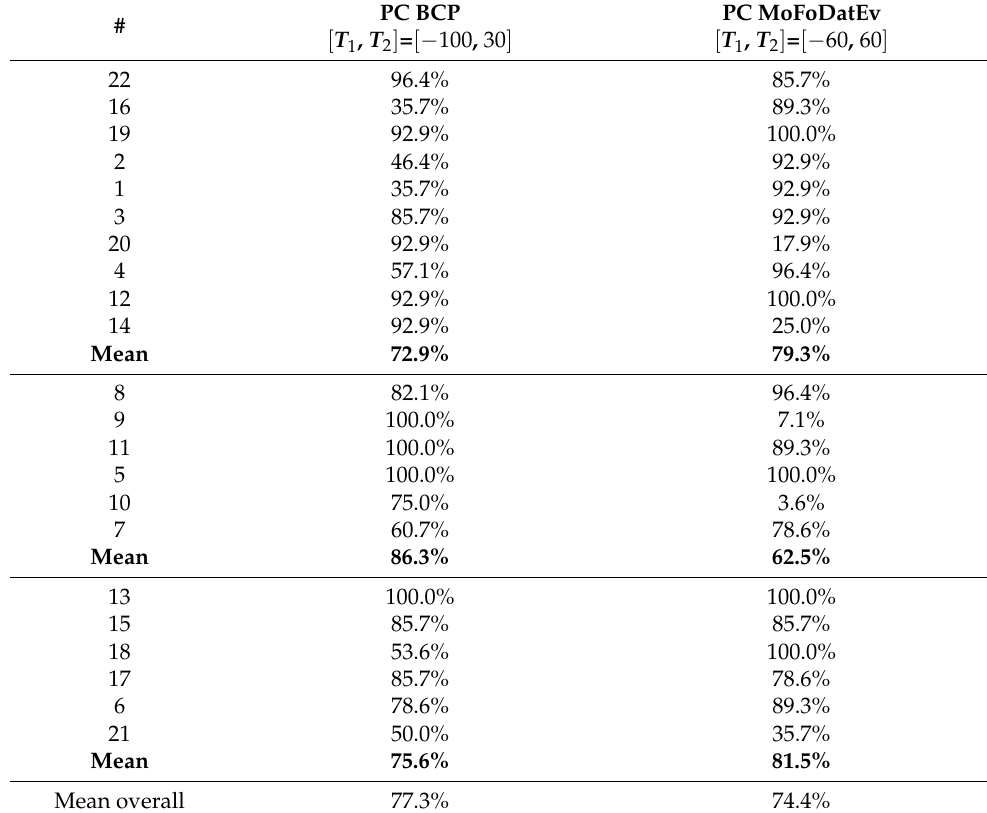
Table 6. Comparison of the PC results for leakage localization with a BCP algorithm and